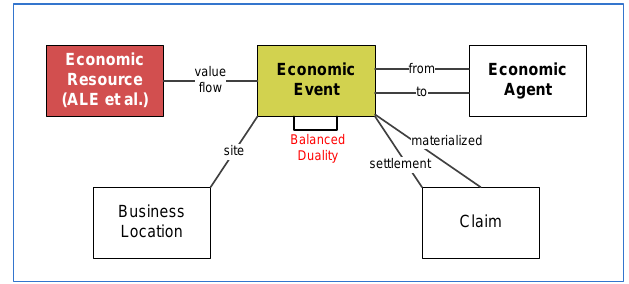
Figure 6. REA-based ALE Accounting model (refined) – UML language